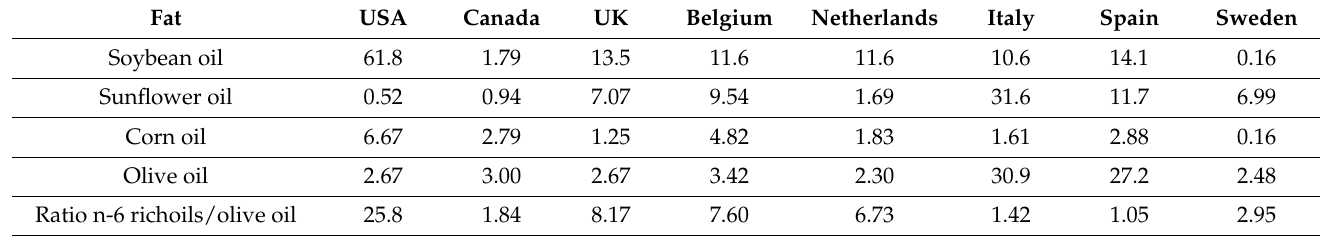
Table 1. Calculated fat intake in g/capita/day of commonly used vegetable oils, dairy fats, raw animal fat and fish (sum of demersal, pelagic and other marine fishes) in the USA, Canada, the United Kingdom, Belgium, The Netherlands, Spain, Italy and Sweden according to the Food and Agriculture Organization of the United Nations (FAO) 2019 (www.fao.org/faostat/en/#data/FBS, accessed on: 9 February 2022). + indicates that information aout butter is